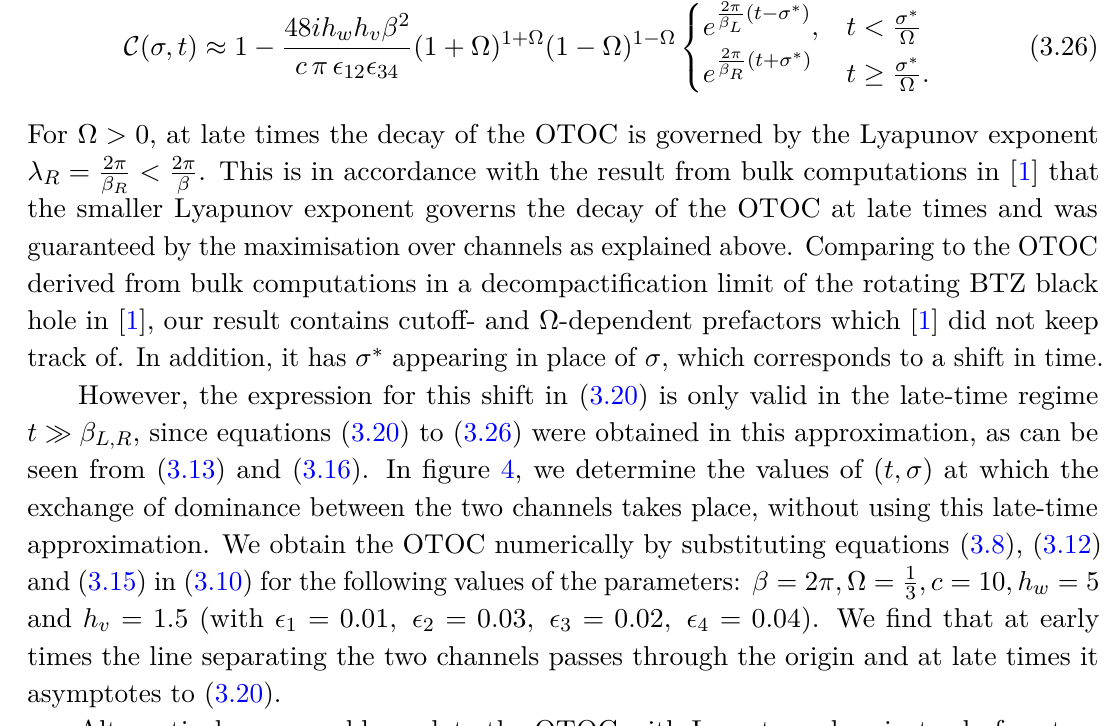
Figure 4 . Regions with the two Lyapunov growths separated by the black dashed line, which for early times intersects the origin and for late times asymptotes to t = σ ∗ numerically for the following values of parameters: β = 2 π, Ω = 1 For negative σ , in conventions where Ω > 0 , the slower Lyapunov exponent determines the growth with time in the future lightcone. For positive σ , one encounters first the faster and then the slower Lyapunov